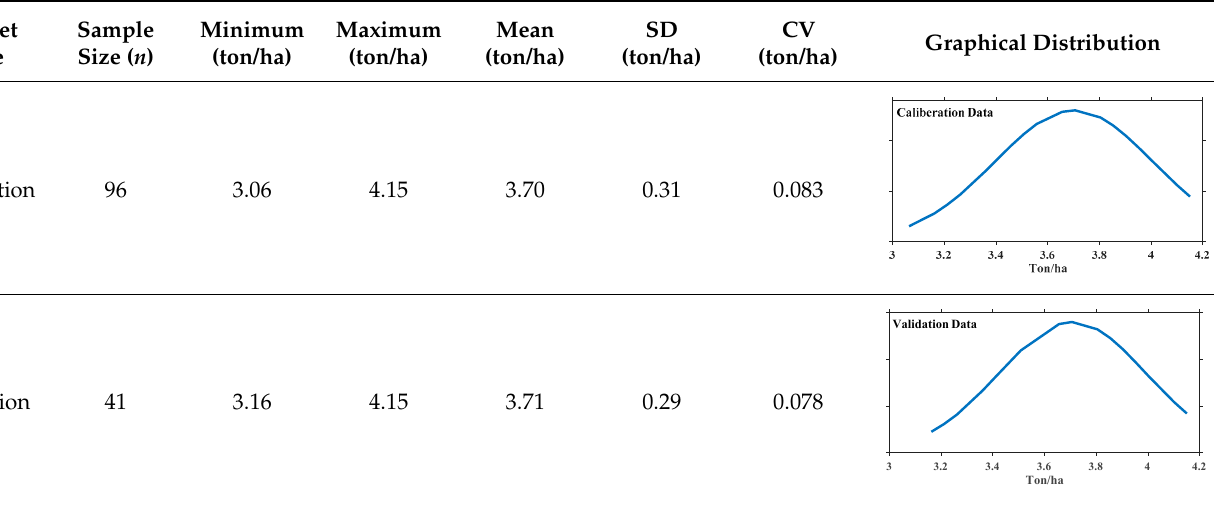
Table 2. Statistical description of the field measured rice yield with graphical displays of calibration and validation datasets.